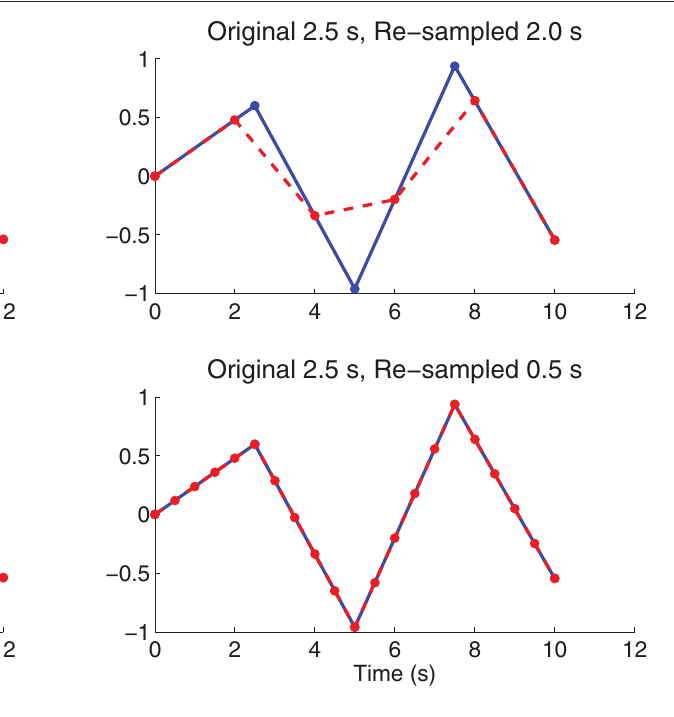
FIGURE A1 | Figure shows sine waves (blue) with original sampling periods of 2.0 or 2.5s as well as re-sampled curves (red) with re-sampling periods of 2.0 or 0.5s. Red curves were linearly interpolated from blue curves. Re-sampling from 2.0 to 2.0s ( upper-left panel ) leaves the curve unchanged. Re-sampling from 2.5 to 2.0s ( upper-right panel ) causes